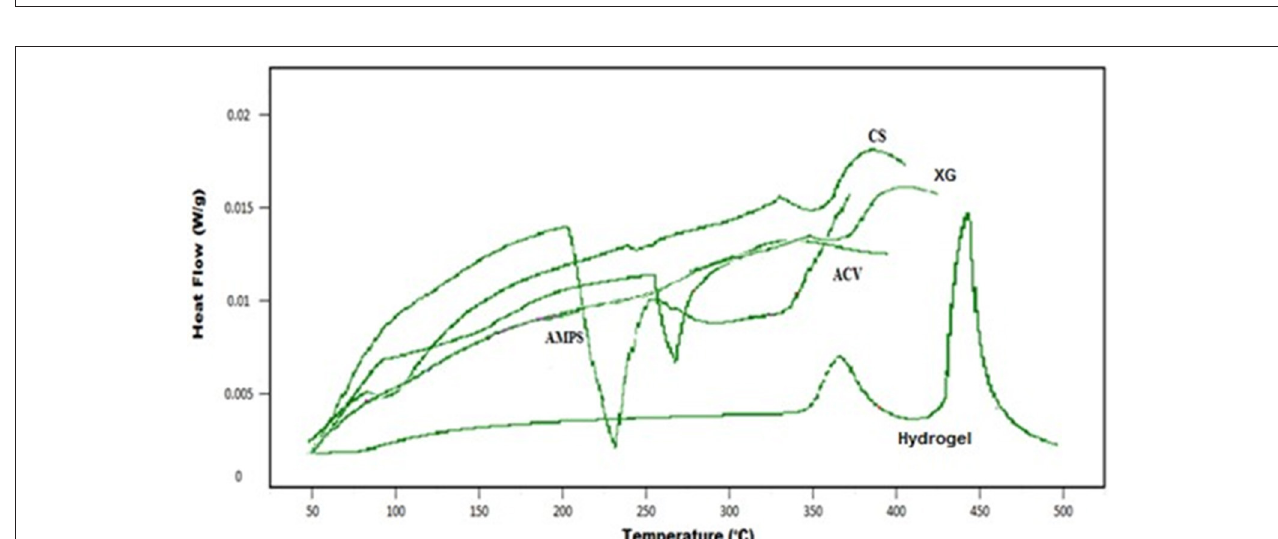
FIGURE 3 | DSC curve of ACV, AMPS, CS, XG, and Hydrogel.